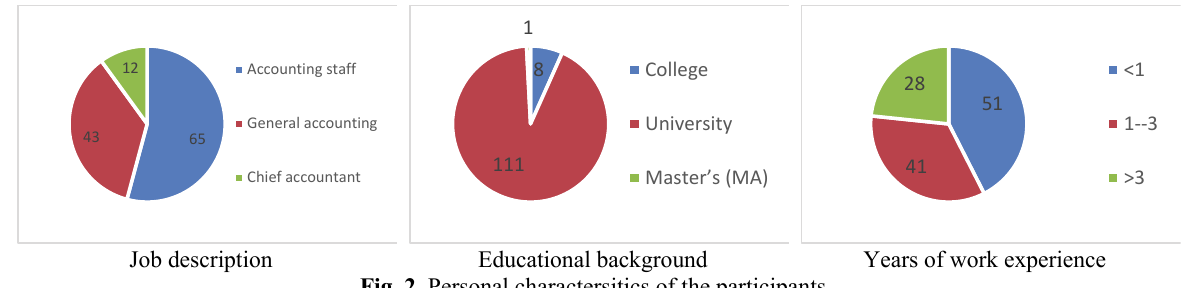
Fig. 2. Personal charactersitics of the participants